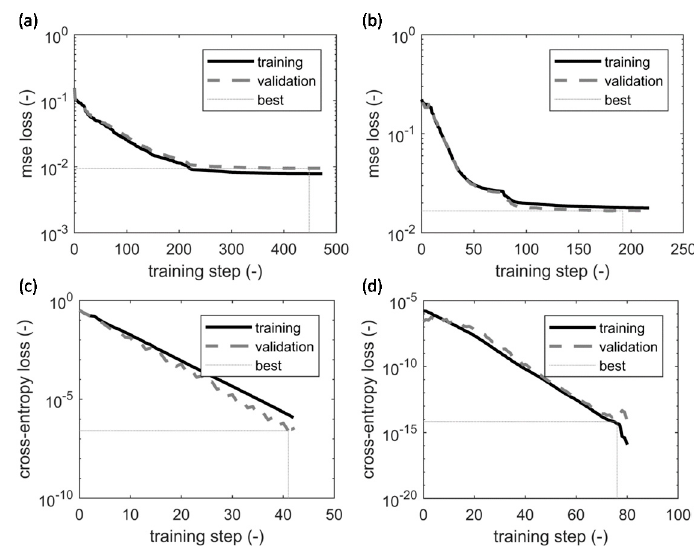
Figure 10. Learning curves: ( a ) the first autoencoder; ( b ) the second autoencoder; ( c ) the softmax layer;( d ) the stacked deep learning network. Aerospace 2018 , 5 , x FOR PEER REVIEW